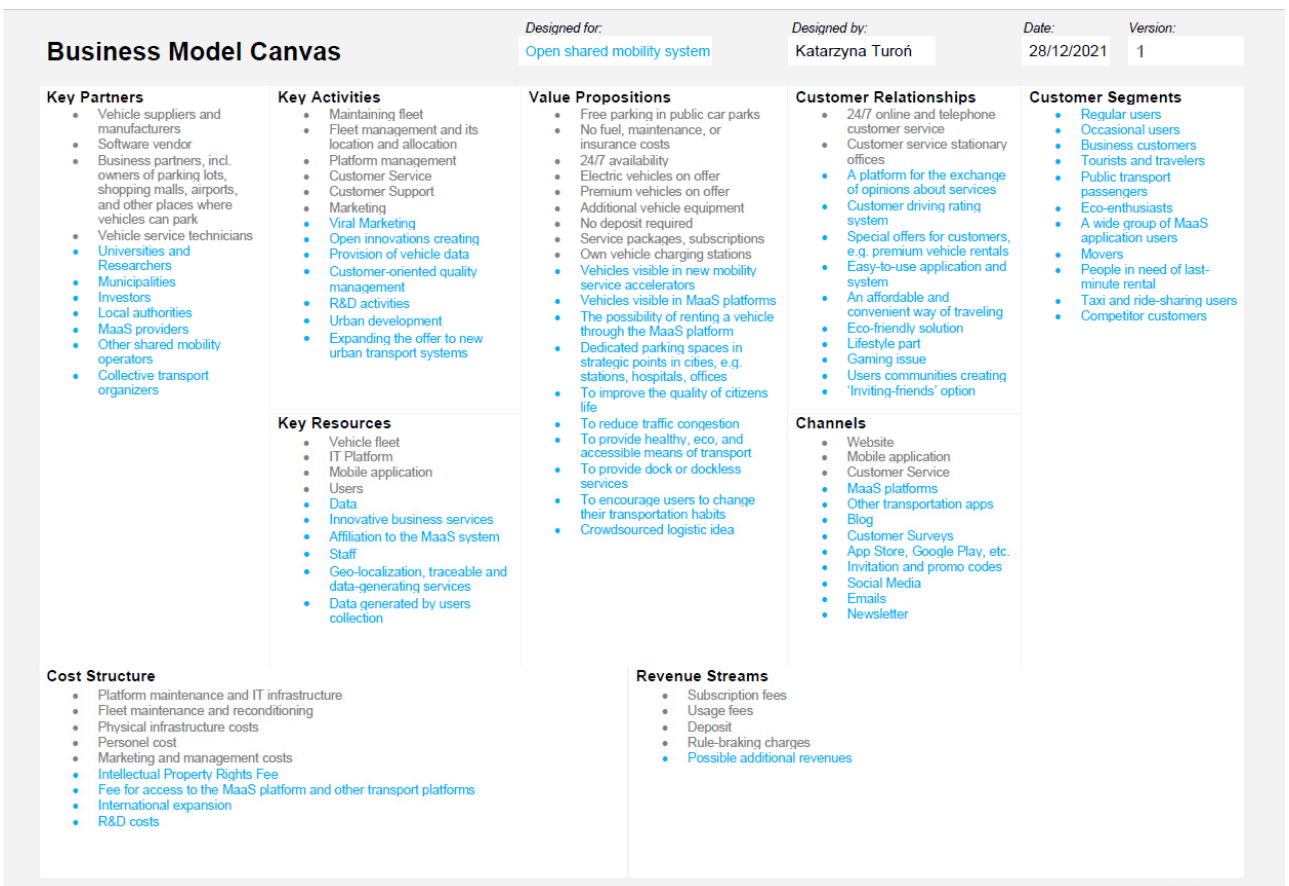
Figure 5. Open shared mobility business model based on the CANVAS concept. Source: author’s own elaboration.